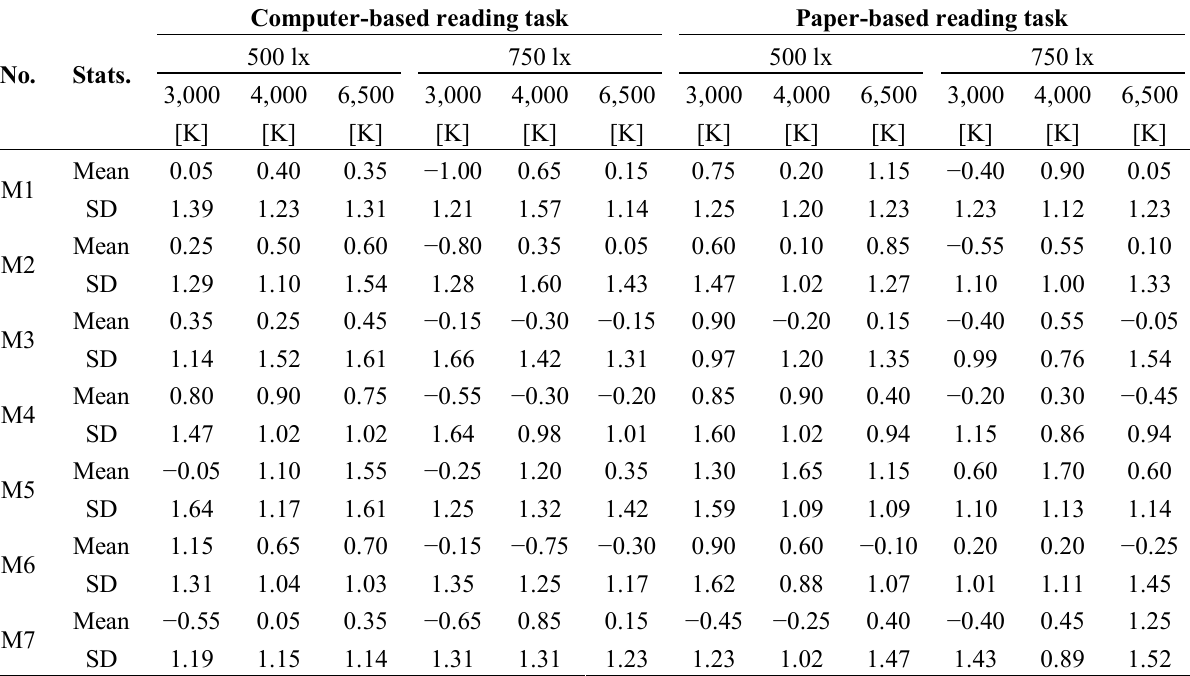
Table 4. Mood Perception under illuminance and color temperature